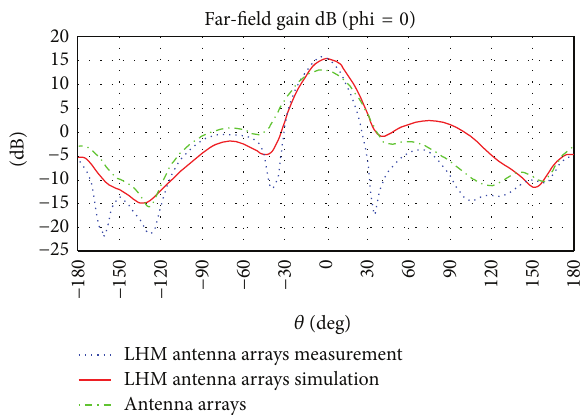
Figure 22: Radiation pattern of fabricated FL-LHM antenna arrays in simulation and measurement.